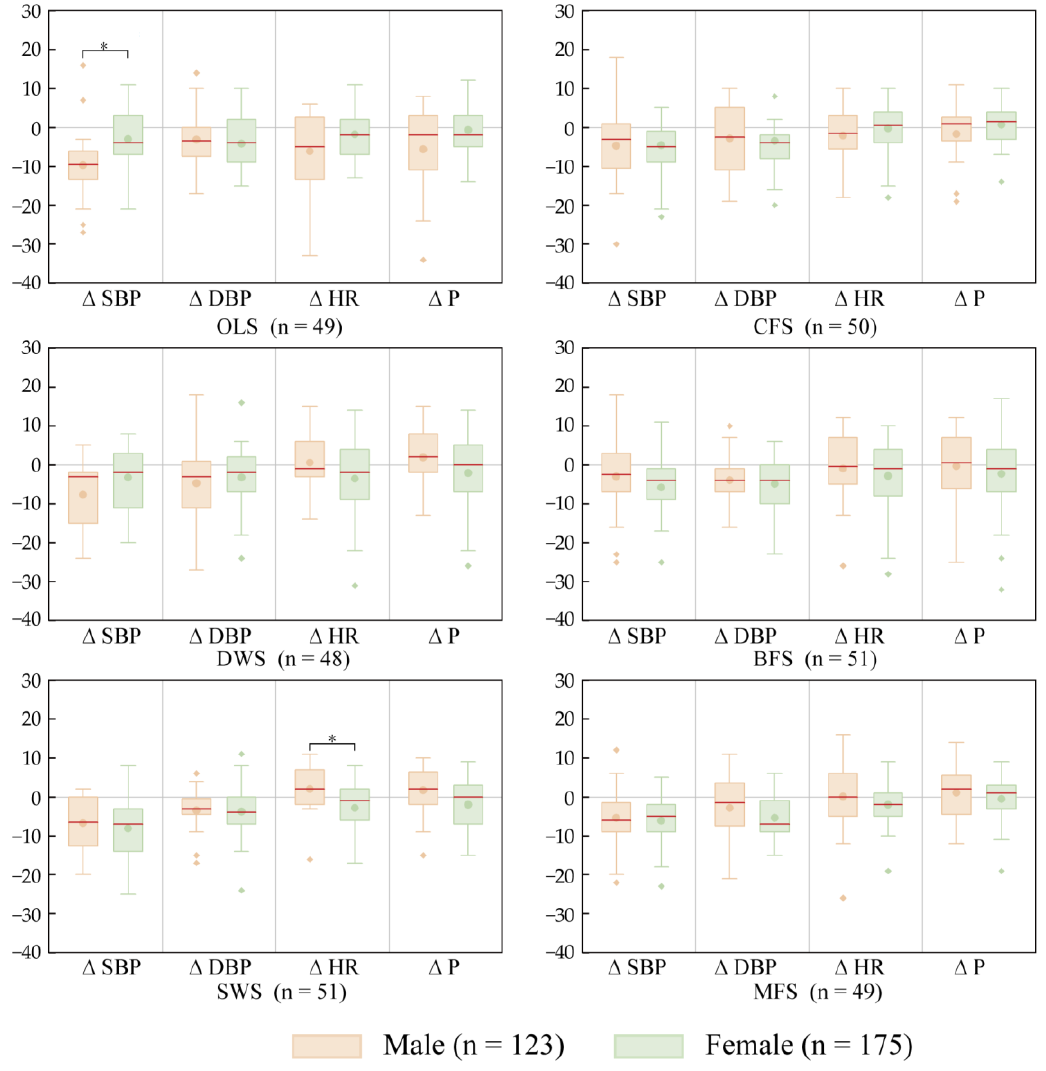
Figure 4. Differences in physiological response changes in participants of different gender in each forest landscape space. * p < 0.05. OLS: overlook landscape space ( n = 49); DWS: dynamic water landscape space ( n = 48); SWS: static water landscape space ( n = 51); CFS: coniferous forest landscape space ( n = 50); BFS: broadleaf forest landscape space ( n = 51); MFS: mixed forest landscape space ( n = 49).